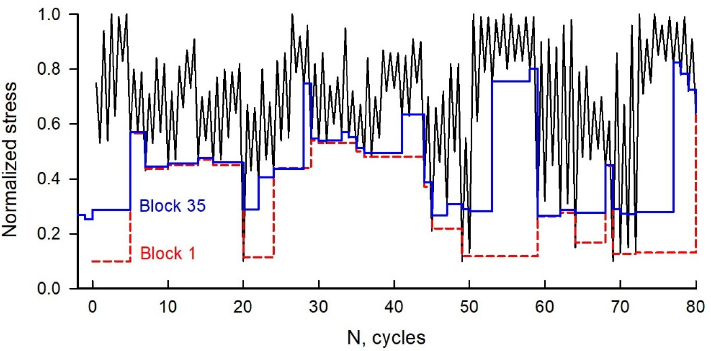
Figure 12. Part of Cold Turbistan+ spectrum loading and calculated crack-opening-stress ratios.